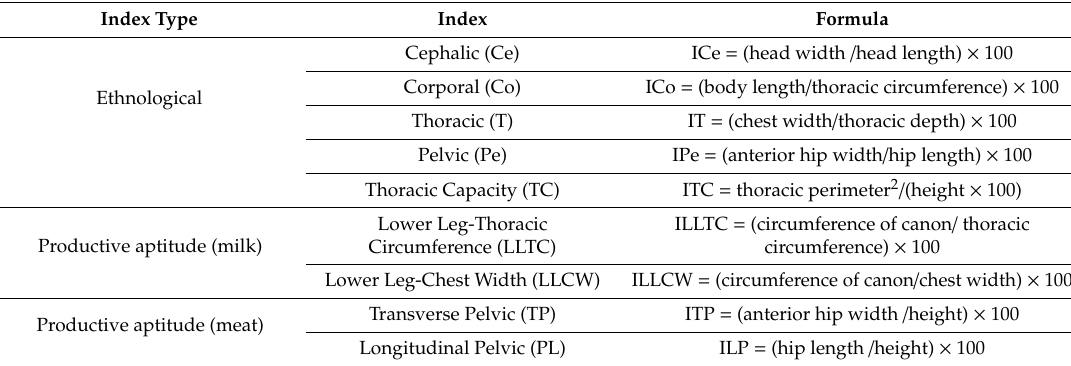
Table 1. Zoometric indexes determined in the adult Criollo Lojano